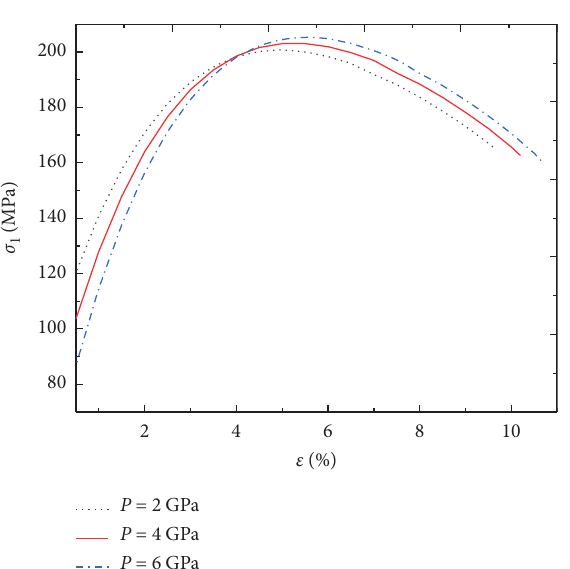
Figure 5: The real stress σ ( ε ) of Au Cu Si at P � 2, 4, and 6 GPa and T � 300K calculated by the SMM. 1 87 10 3 Table 6: Values of ε � f F ( f ( ε F ) max ), σ 1max , ε e , and σ e for Au 88 Cu 10 Si 2 at P � 2, 4, and 6GPa and T � 300K calculated by the SMM. P (GPa) ε F